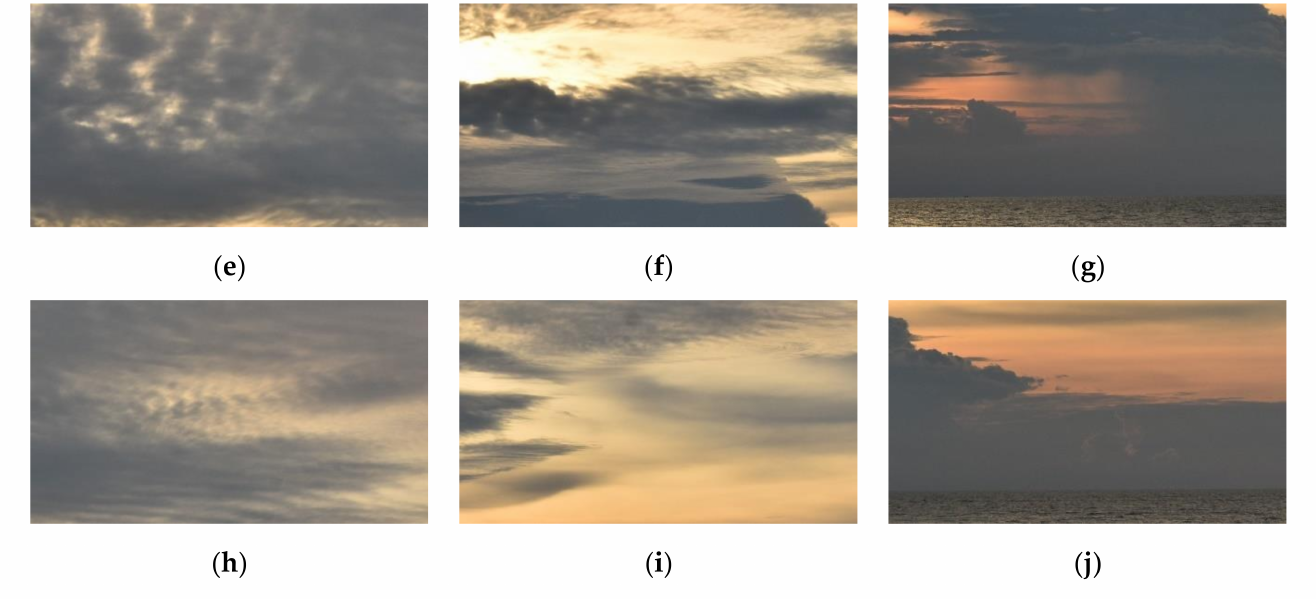
Figure 3. ( a ) Source raw image; ( b – j ) Extracted sub-images; ( d , g , j ) Selected images with visible SHL.